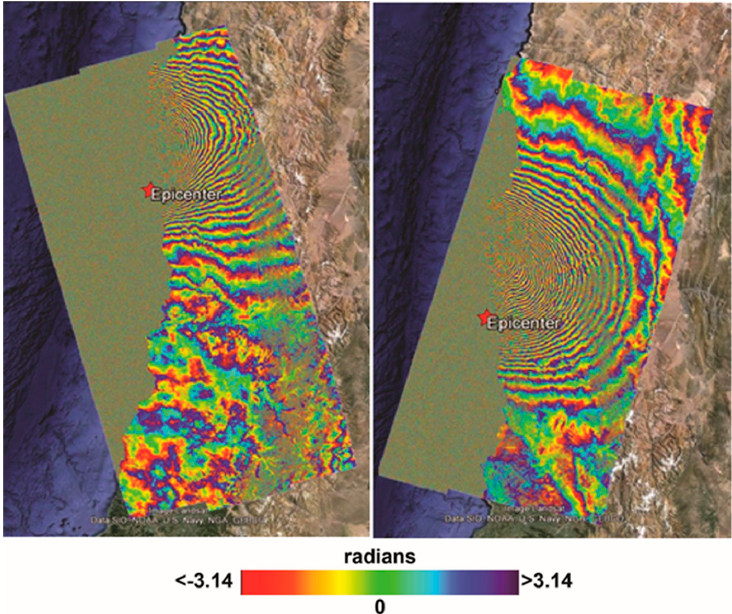
Figure A1. Wrapped interferograms superimposed on a satellite Google Earth image. ( left ) 26 August 2015–19 September 2015 inteferogram along the ascending orbit (Track 18) ( right ) 31 July 2015–17 September 2015 inteferogram along the descending orbit (Track 156). The red star is the main shock epicenter.